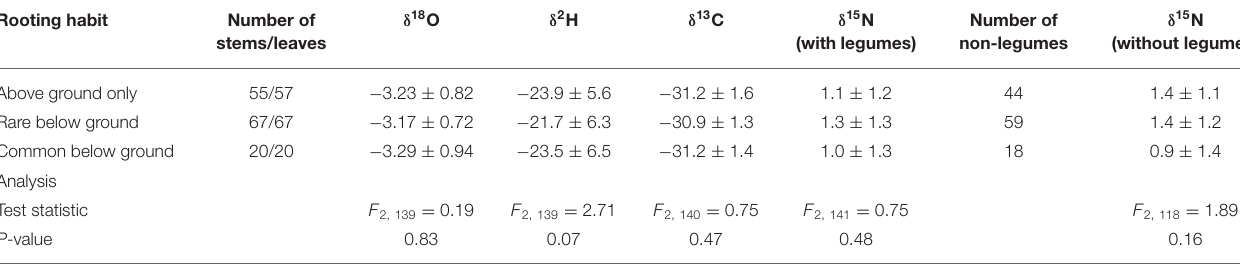
TABLE 2 | Mean and standard deviation (1 σ ) of stem water δ 18 O and δ 2 H as well as leaf δ 13 C and δ 15 N by rooting habit groups. Rooting habit